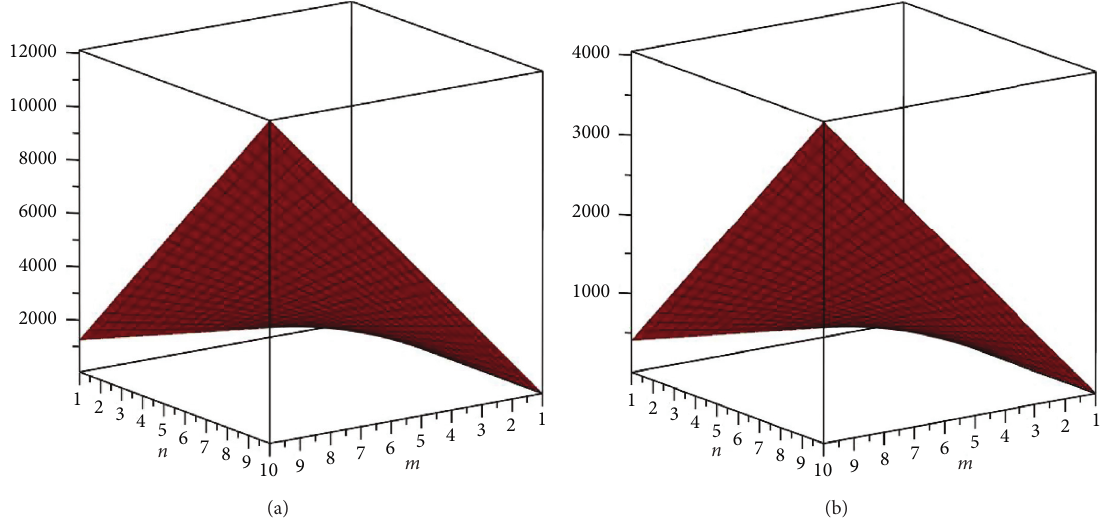
Figure 5: (a) The first Zagreb β -index (I). (b) The second Zagreb index.